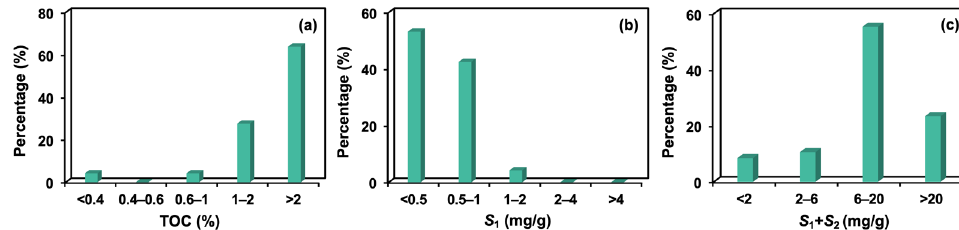
Figure 2. Organic geochemical characteristics of shales in Well Qiang21. ( a ) Total organic carbon (TOC) content distribution; ( b ) S 1 content distribution; ( c ) S 1 + S 2 content distribution.